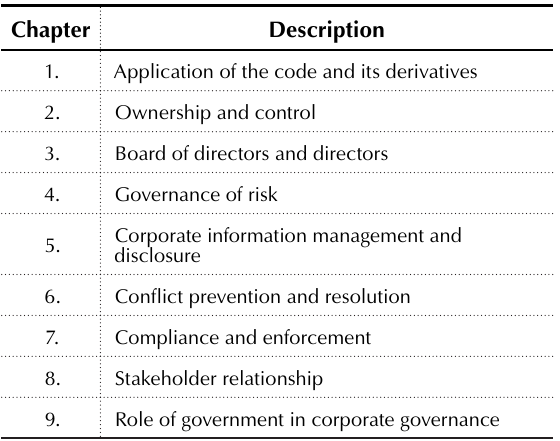
Table 1. Zimbabwe’s National Code of Corporate